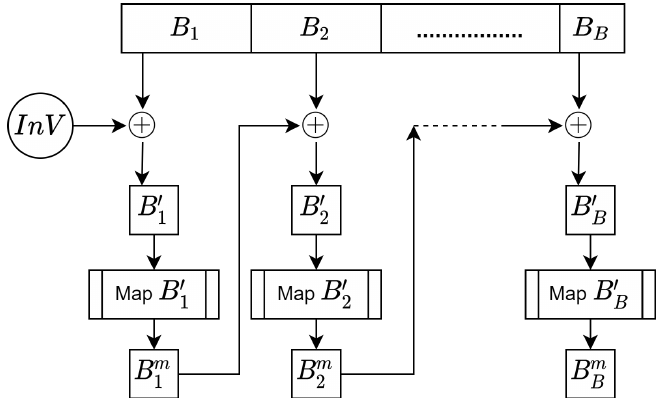
Figure 8. Securing blocks for resistance against encryption attacks using Cipher Block Chaining (CBC). Algorithm 5 describes the process that secures the blocks. Algorithm 5: Securing blocks for resistance against encryption attacks.